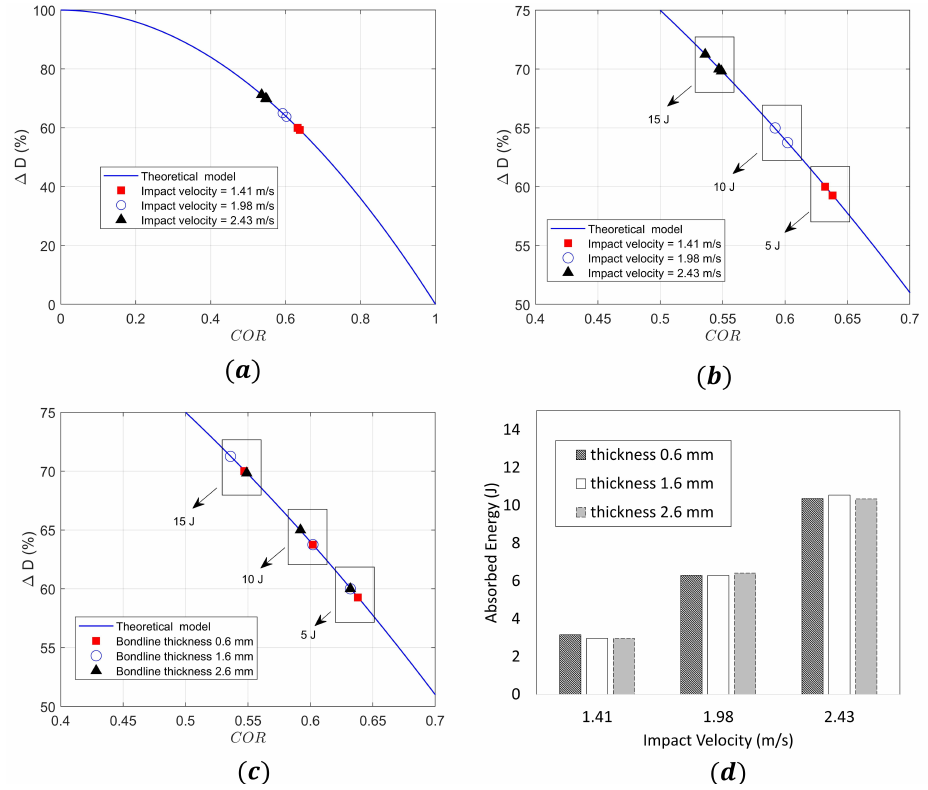
Figure 15. Description of impact kinematics: ( a ) % ∆ D − COR curves for different impact velocities, ( b ) magnified image showing variation of COR and % ∆ D , ( c ) % ∆ D − COR curves for different bondline thicknesses, and ( d ) absorbed energy in the specimens for different impact velocities and bondline